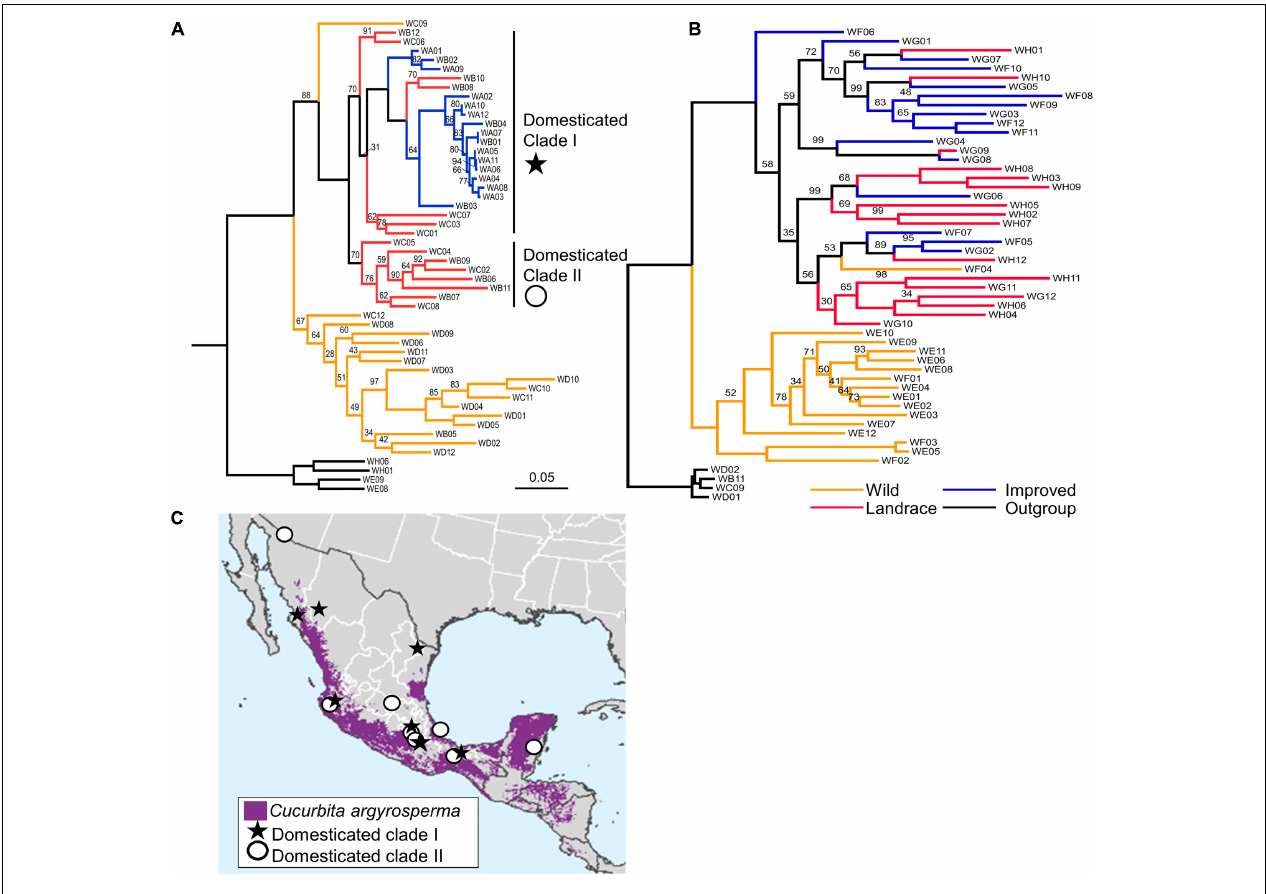
FIGURE 4 | Results of phylogenetic analysis of (A) Cucurbita argyrosperma accessions and (B) Cucurbita maxima accessions. Branches are colored by improvement status. Bootstrap values of 100 are not shown. Two clades of domesticated C. argyrosperma are indicated by Domesticated Clade I and Domesticated Clade II (C) Map of sampling localities of C. argyrosperma landraces with samples’ membership in Domesticated Clade I or Domesticated Clade II indicated by * or ◦ , respectively. Scale bar indicates the proportion of site changes along each branch.